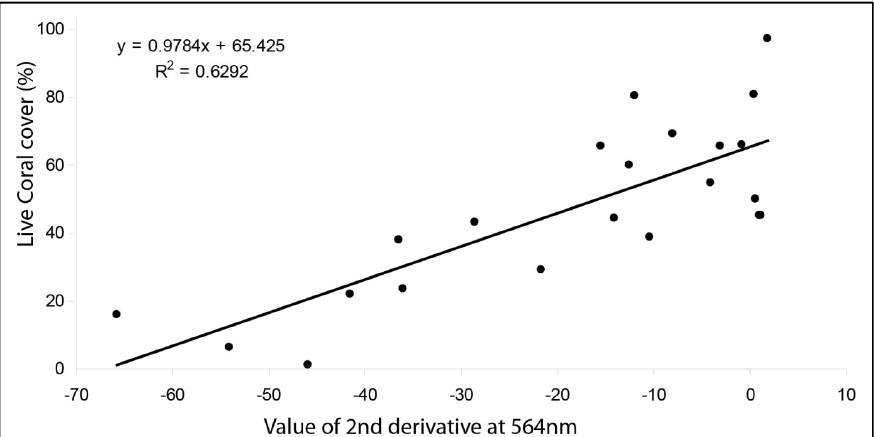
Figure 9. Linear correlation equation determination between live coral cover and 2nd derivative around 564